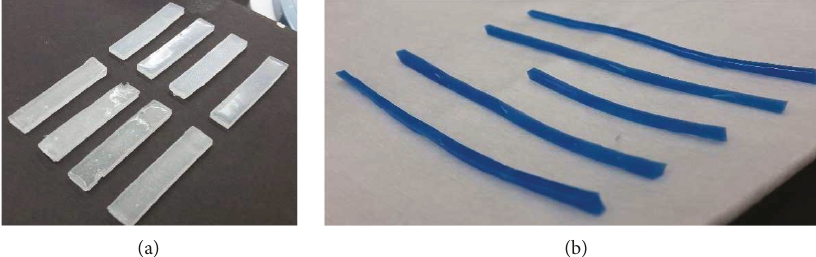
Figure 1: (a) Soft silicone matrix. (b) Hard silicone fi bers used in fabricating the soft tissue composites.